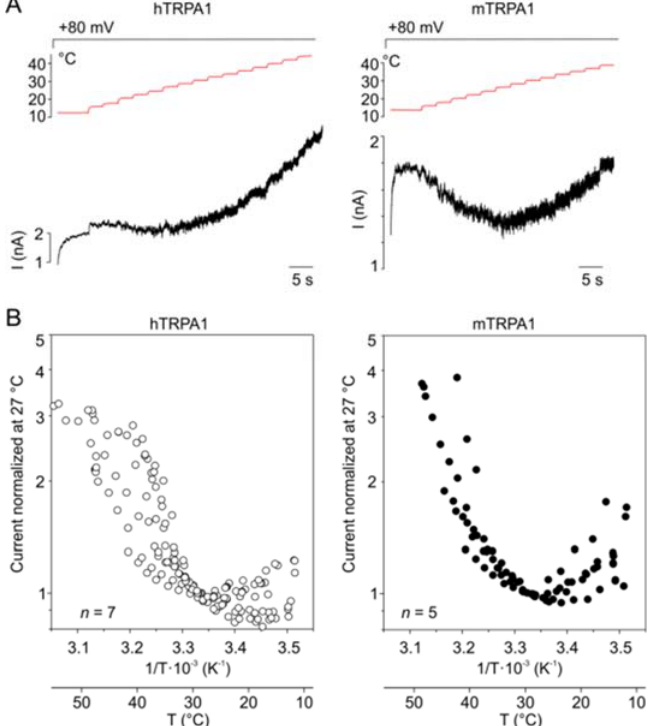
Figure 4. Both TRPA1 orthologues exhibited U ‐ shaped outward currents. ( A ) Representative whole ‐ cell currents of hTRPA1 (left) and mTRPA1 (right) elicited by the simultaneous activation of the voltage and temperature sensors at the holding potential of +80 mV and the temperature sensors by using increasing steps of temperature from ~11 to ~52 °C, as indicated above. ( B ) Arrhenius plots of currents normalized at 27 °C obtained from measurements, as in ( A ) for indicated ( n ) number of cells.